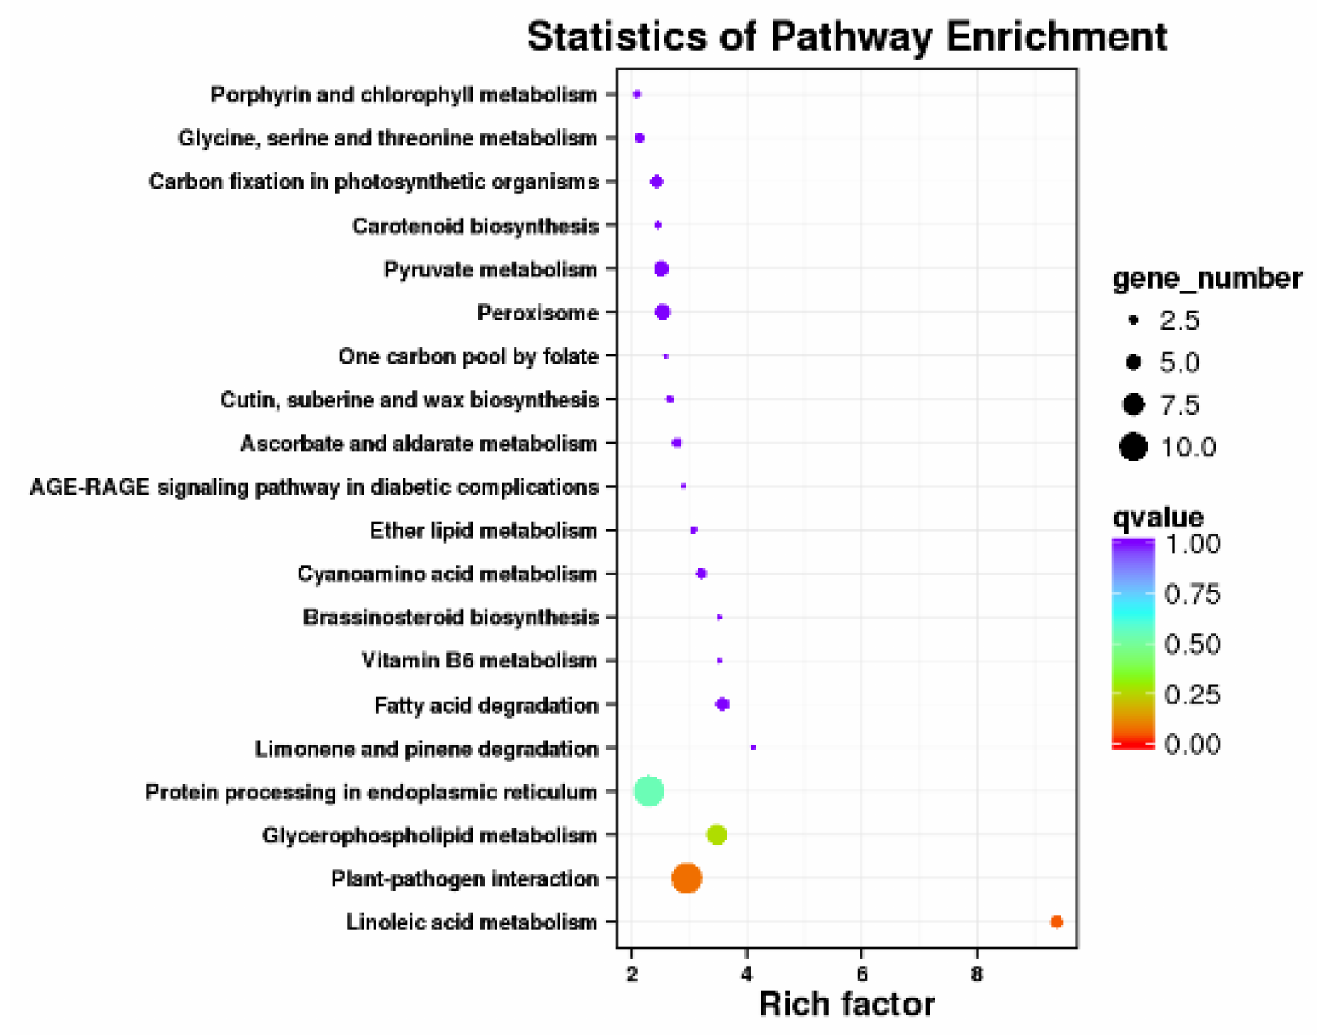
Figure 5. KEGG pathway enrichment of significantly differentially expressed genes (Log2fold change ≥ 2 and FDR p -value ≤